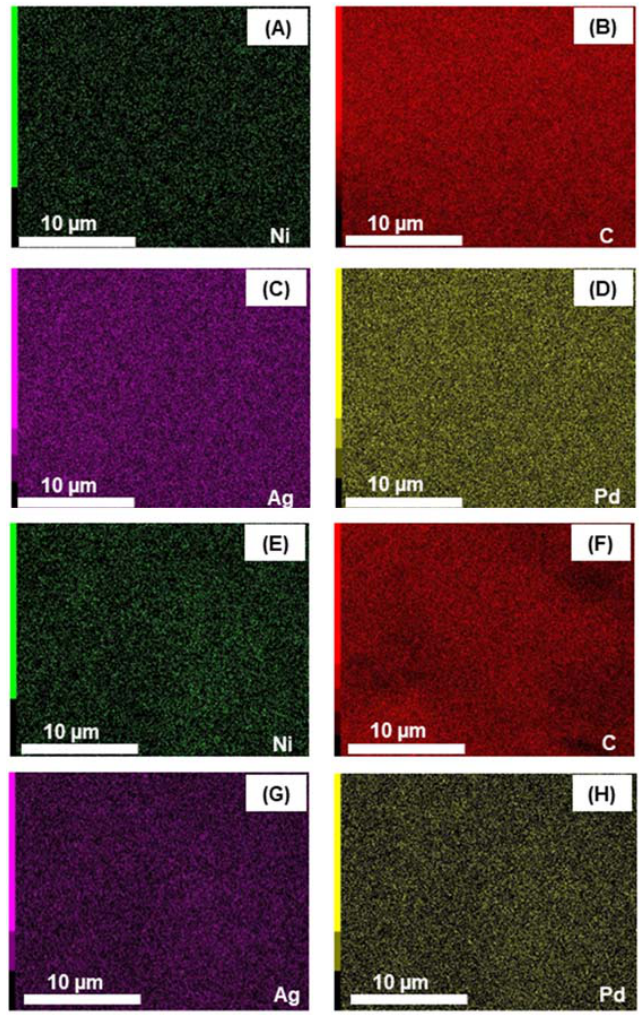
Figure 2. EDS elemental maps of Pd 4 Ag 2 Ni 1 /C ( A – D ) and PdAgNi/C ( E – H ) taken at 10 kV.